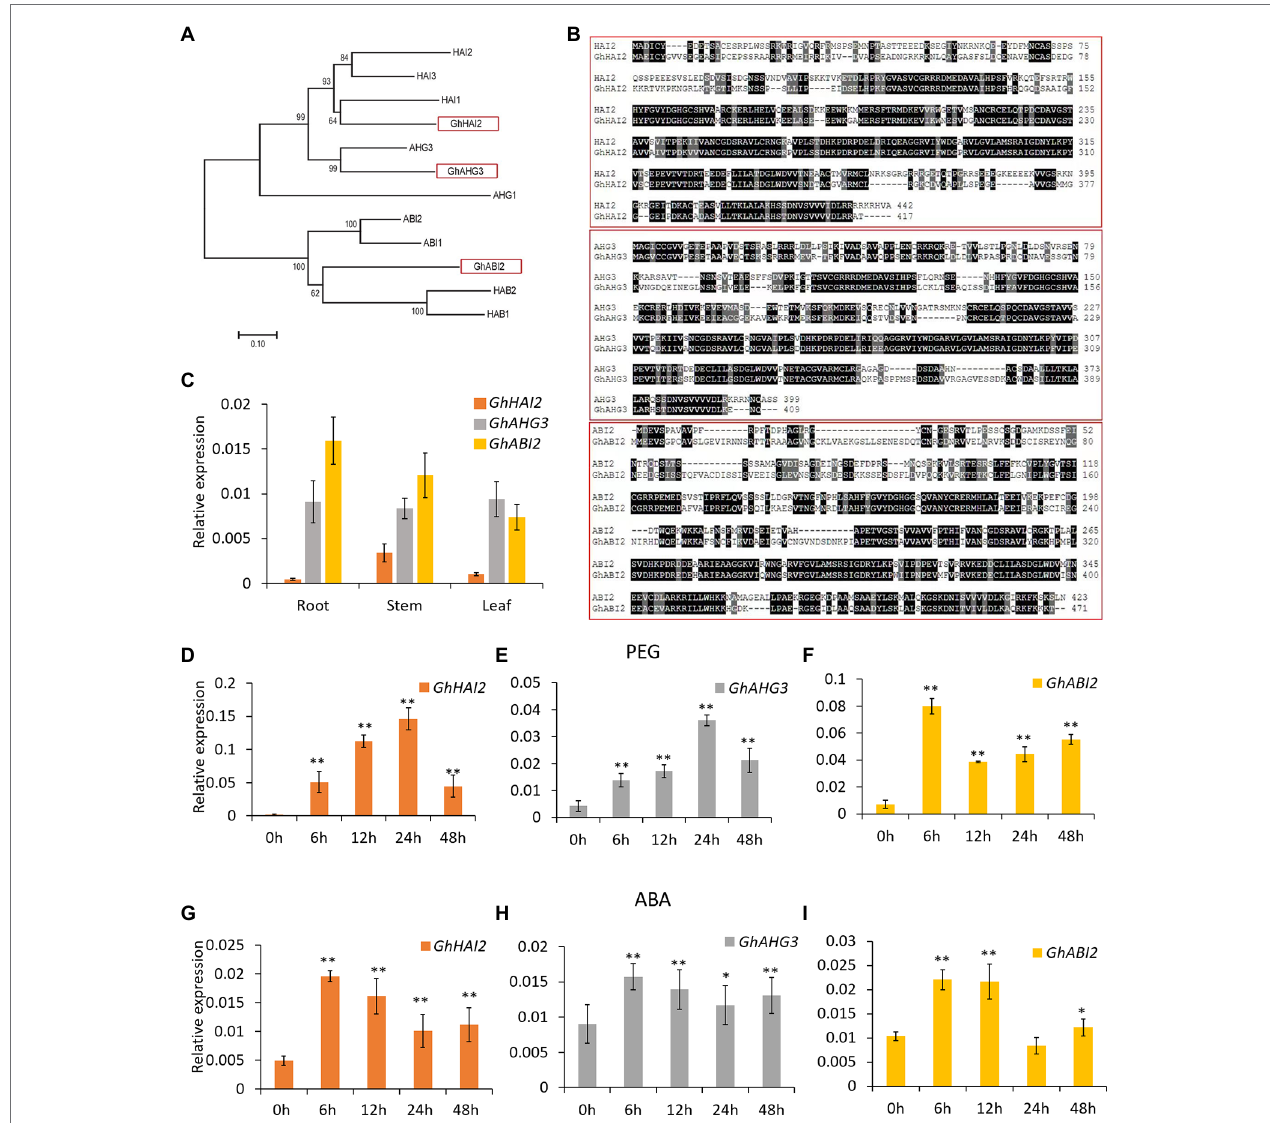
FIGURE 1 | Sequence analysis and expression pattern of GhHAI2 , GhAHG3, and GhABI2 in different tissues and after exposure to PEG and ABA. (A) Phylogenetic analysis of GhHAI2, GhAHG3, and GhABI2 and Arabidopsis group A PP2Cs. The neighbor-joining tree was constructed using MEGA software (version 7.0) based on multiple alignments of GhHAI2, GhAHG3, and GhABI2 protein sequence and their homologous proteins in Arabidopsis . (B) Comparisons of deduced amino acid sequence of GhHAI2, GhAHG3, and GhABI2 with those of Arabidopsis . Identical amino acid residues are highlighted in black. (C) qPCR analysis of GhHAI2 , GhAHG3, and GhABI2 genes expression levels in three different tissues. (D–F) PEG- and (G–I) ABA-induced expression pattern of GhHAI2 , GhAHG3, and GhABI2 genes. Bars represent means ± standard deviation of three biological replicates. Asterisks represent statistically significant differences compared with untreated control (0 h; Student’s t -test; * p < 0.05; ** p <